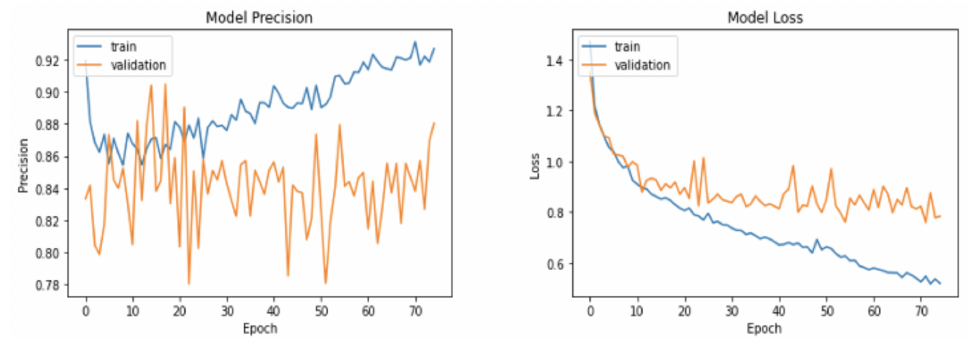
Figure 8. High regularization in the model training graphs due to the batch normalization after the first MLP